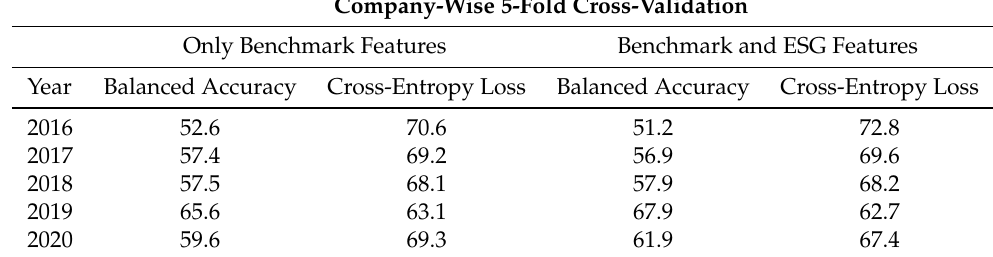
Table 2. Performance measures in percentage on the test set for both types of validation splits. The numbers for the company-wise splits are the median values of the performance of 100 random samplings of 5 models among 100 random company-wise validation splits.